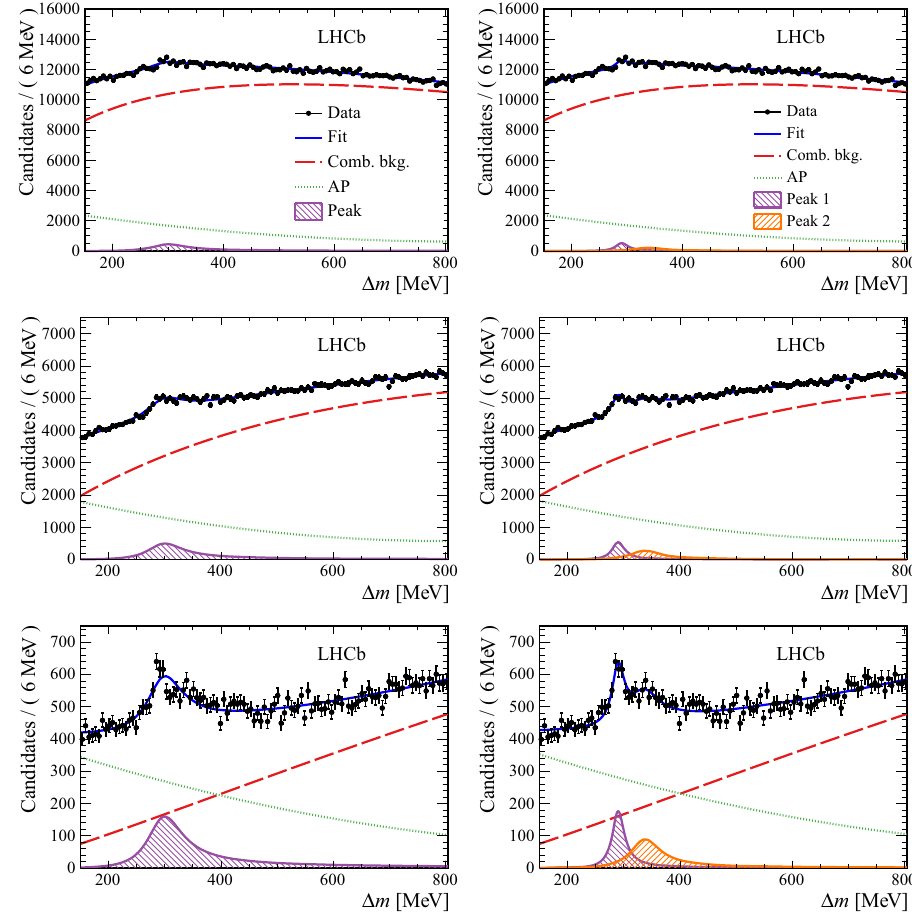
Fig. 1 The B + K − mass difference distributions in data, overlaid with the fit models: (left column) one-peak hypothesis and (right column) two-peak hypothesis. In each column, the rows are from top to bottom for candidates with the prompt kaon p T : 0 . 5 < p T < 1 GeV, 1 < p T < 2 GeV, and p T > 2 GeV. The legend in the top row applies for each column. The associated production (AP) background is described by a second-degree polynomial in each fit. The combinatorial background shape is fixed from a fit to the B + K + mass difference distributions